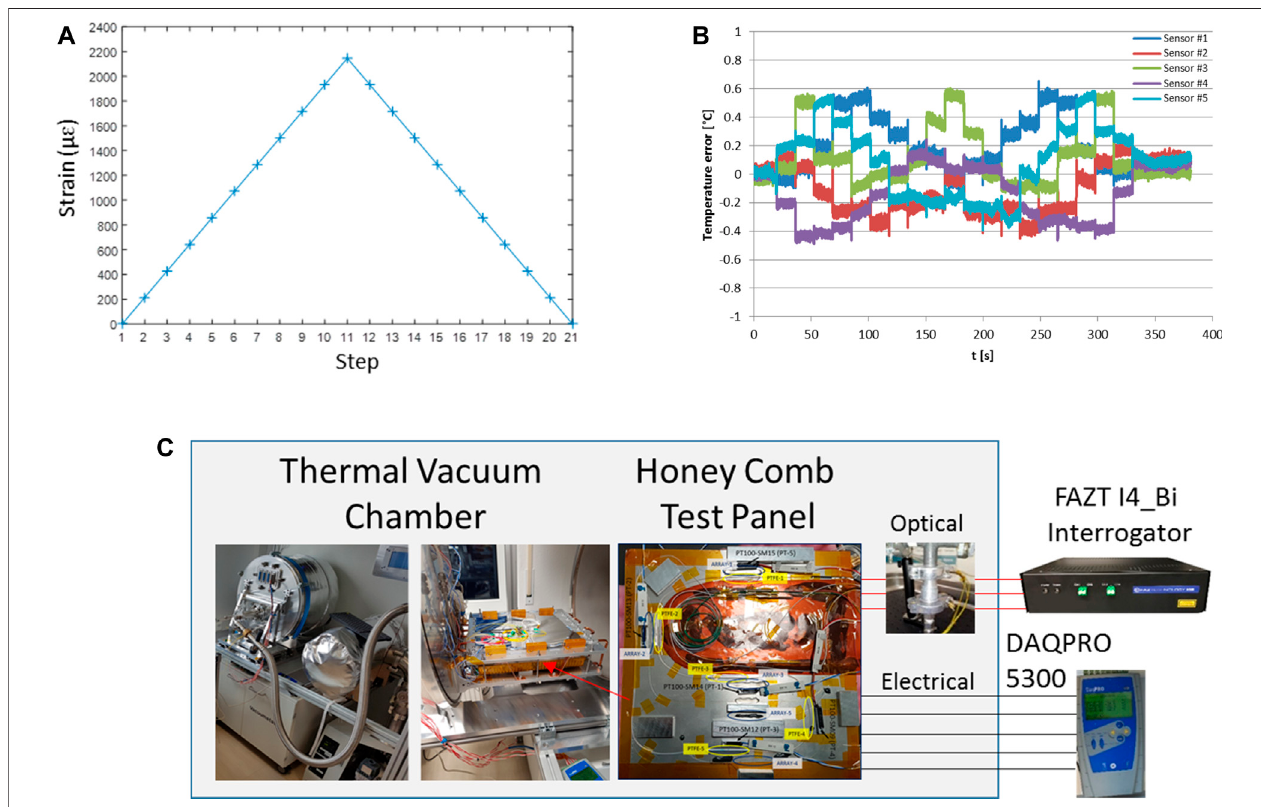
FIGURE 6 | (A) Linear longitudinal strain steps (0µ ε → +2145µ ε → 0µ ε ) applied to a 5 × PM-FBG (Ormocer coated PM-DTG), (B) Strain induced temperature measurement error for a calibrated 5 × PM-FBG array (Ormocer coated PM-DTG) for the corresponding strain (0µ ε → +2145µ ε → 0µ ε ), (C) Thermal vacuum chamber setup showing test panel containing PM-DTGs and sandwiched between heating/cooling